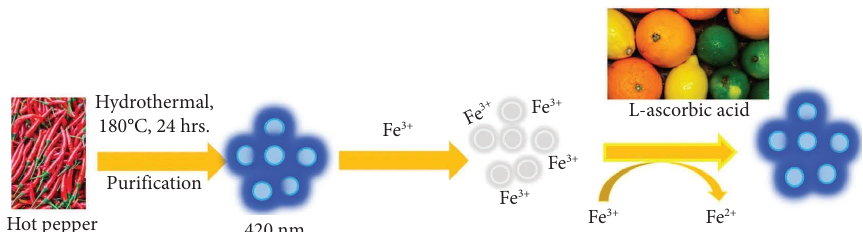
Figure 1: Schematic diagram of the hydrothermal preparation of the HP-CQDs, quenching by the presence of ferric ions, which is followed by fuorescence recovery by the presence of L-ascorbic